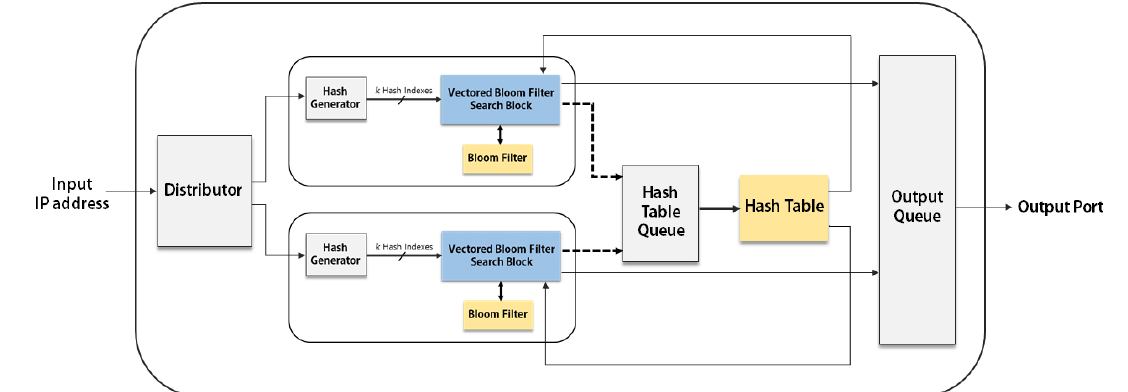
Figure 5. Parallel architecture employing a single hash table: the bold lines represent data paths and the dotted lines represent control